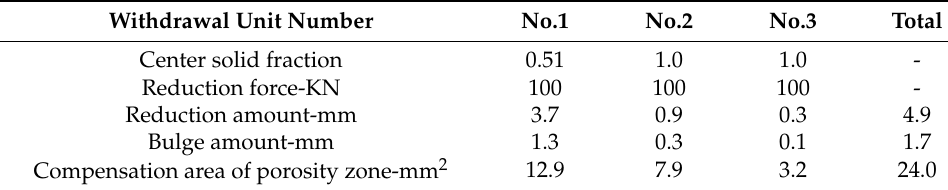
Figure 11. Schematic of multi-unit reduction on round bloom in reduction force mode. Table 1. Reduction parameters during soft reduction